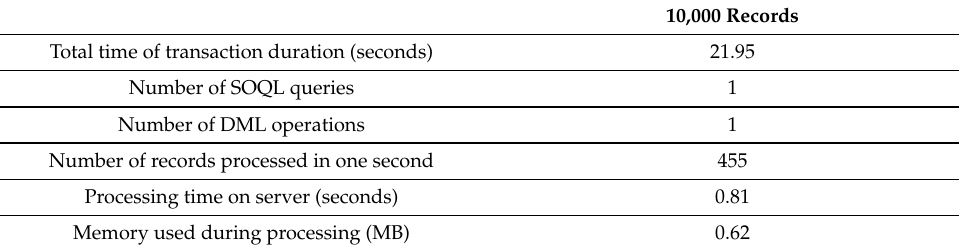
Table 5. Future Apex processing results for delete operation.